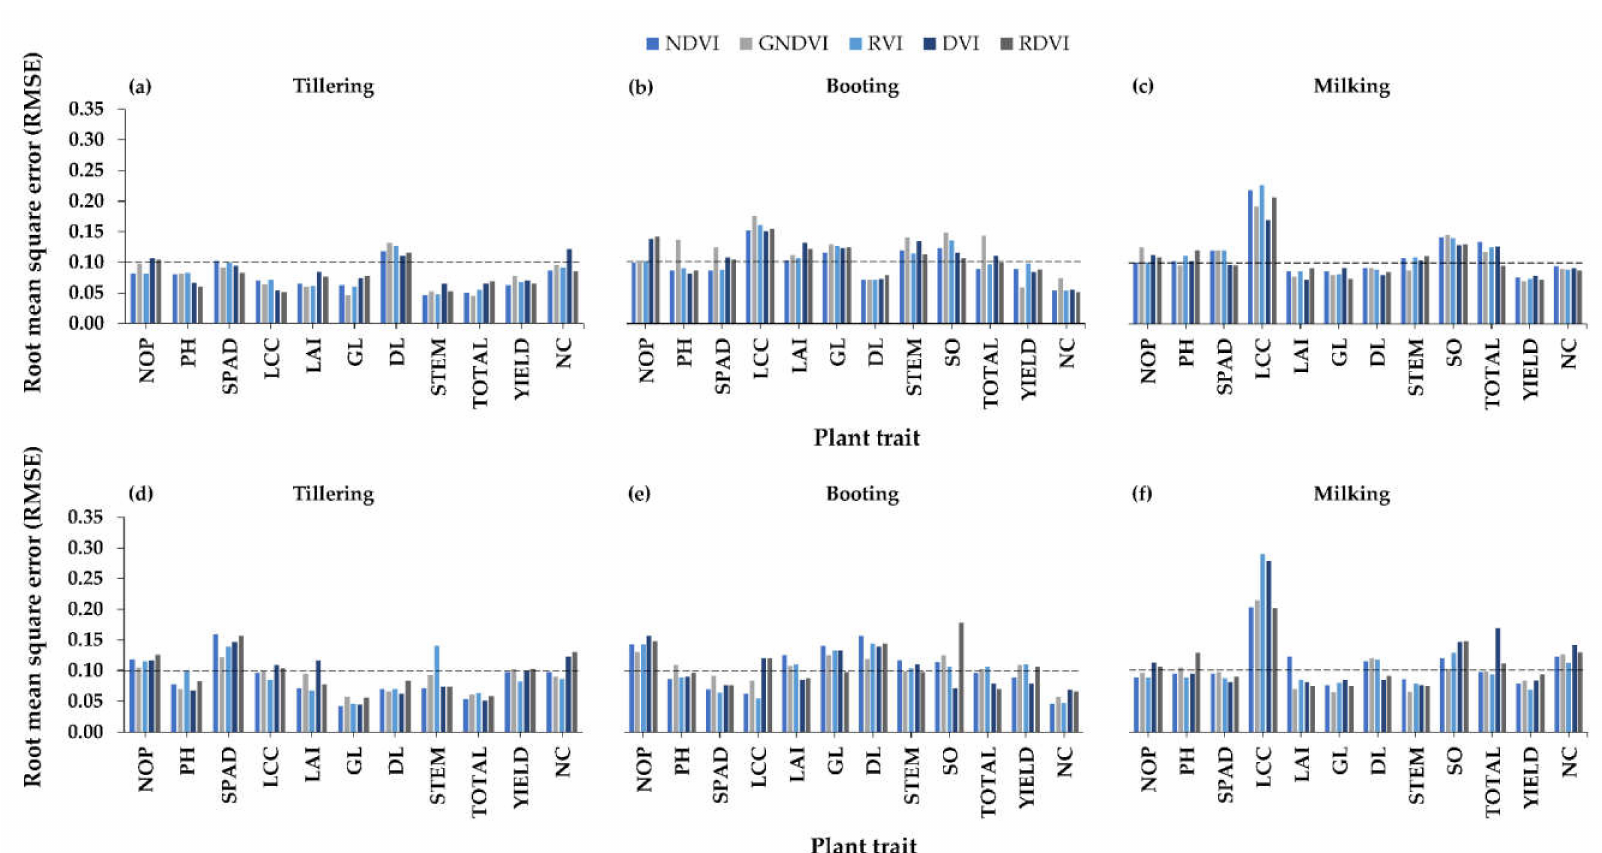
Figure 5. RMSE values for the visible-NIR indices’ training ( a – c ) and testing ( d – f ) models for all plant traits at different rice growth